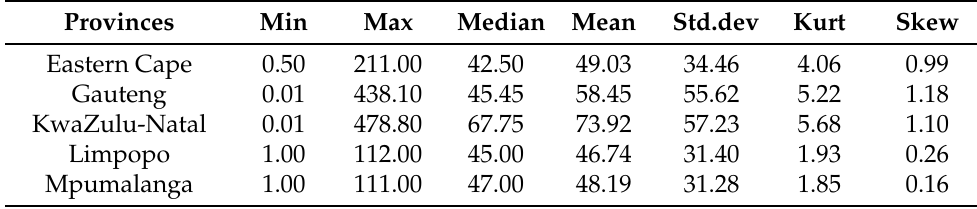
Table 1. Descriptive statistics of the monthly rainfall